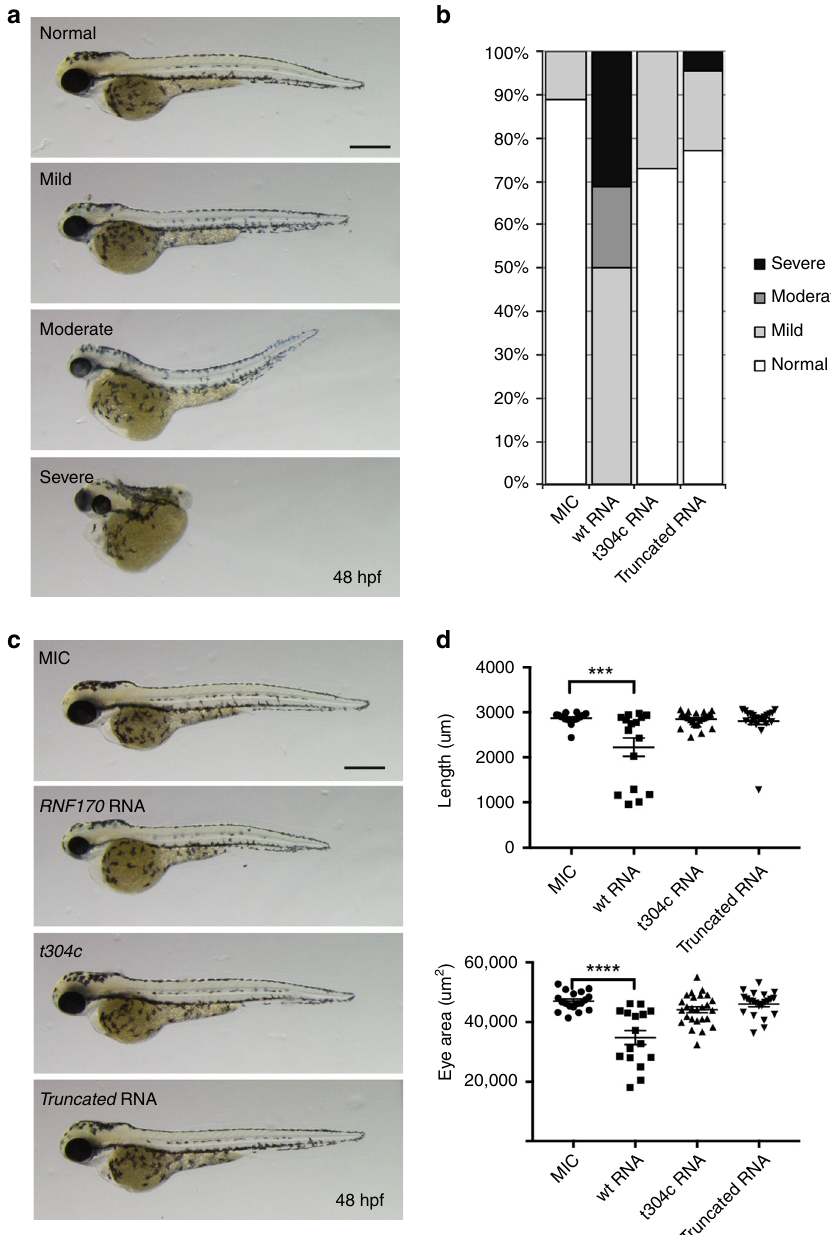
Fig. 5 Overexpression of mutant RNF170 in zebra fi sh. a , b Overexpression of wt but not mutant RNF170 results in morphological abnormalities in zebra fi sh larvae. Representative images showing normal, mild, moderate, and severe morphology phenotypes in live zebra fi sh at 48 hpf. Overexpression of wt RNF170 results in more severe phenotypes when compared with mock injected controls (MIC). Overexpression of truncated RNF170 as well as mutant RNF170 harboring the mutation c.304T>C, which was identi fi ed in family B, does not result in morphological abnormalities implying that the missense mutation results in a loss of protein function. Scale bar represents 400 μ m. c , d Overexpression of wt but not mutant RNF170 results in shortened body axis and smaller eye area. Representative images of MIC ( n = 18) zebra fi sh larvae in comparison with overexpression of wt RNF170 ( n = 16) as well as mutants (c.304T>C, n = 26; and truncated RNA, n = 22) at 48 hpf. Only overexpression of wt RNF170 but not mutant RNF170 (both c.304T>C and truncated RNA) result in reduced body length and eye area in comparison with MIC embryos further delineating a loss of function effect of the mutation